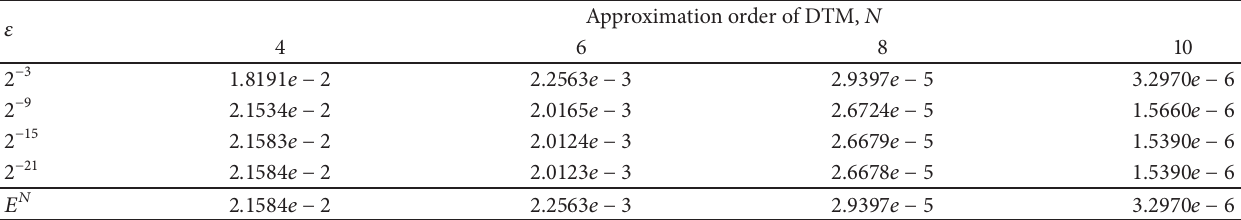
Table 5: Maximum pointwise errors 𝐸 𝑁 𝜀 and 𝐸 𝑁 for the first derivative solution 𝑦 2, ap of Example 2.